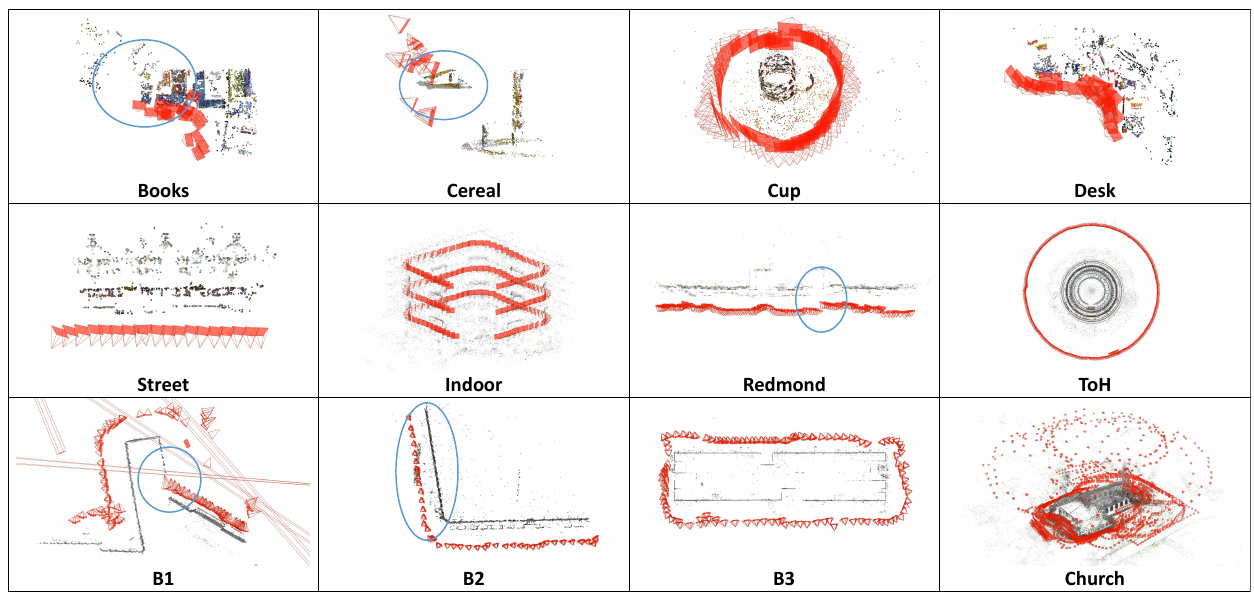
Figure 17. Reconstruction results for various datasets by PSfM, i.e., PRMP-PSfM without iteratively refining match